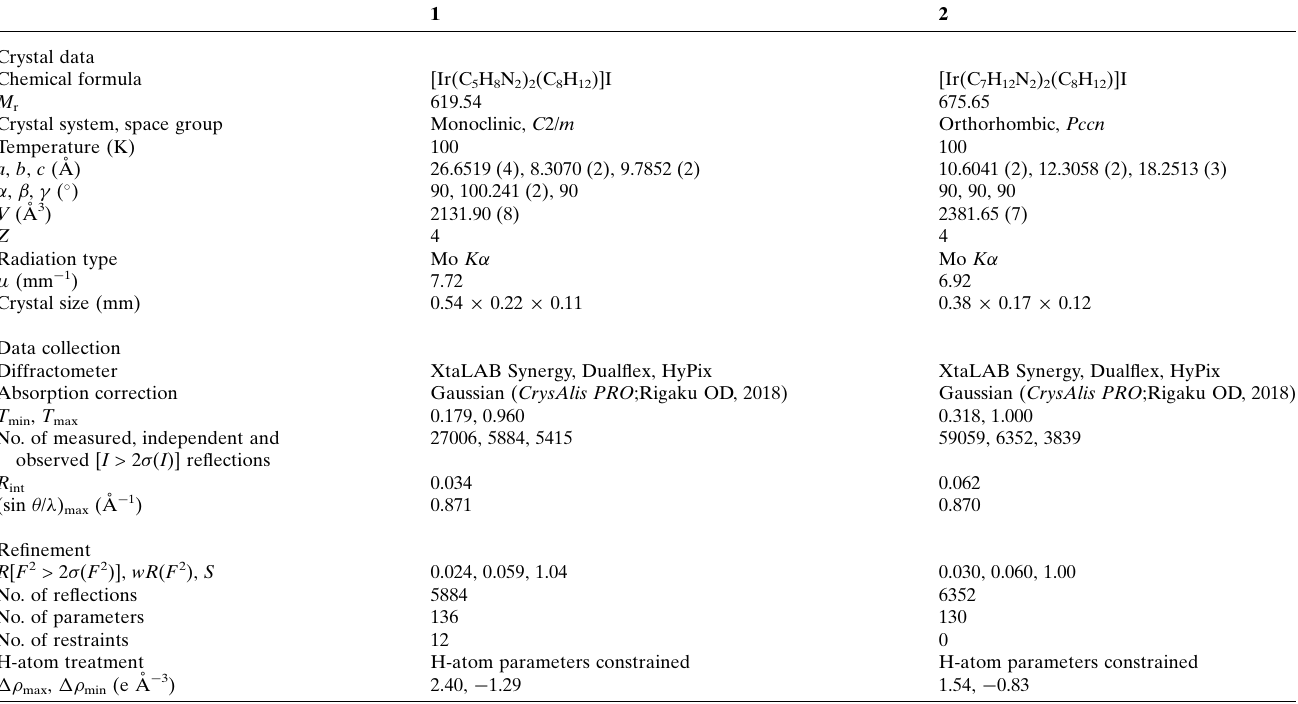
Crystal data Chemical